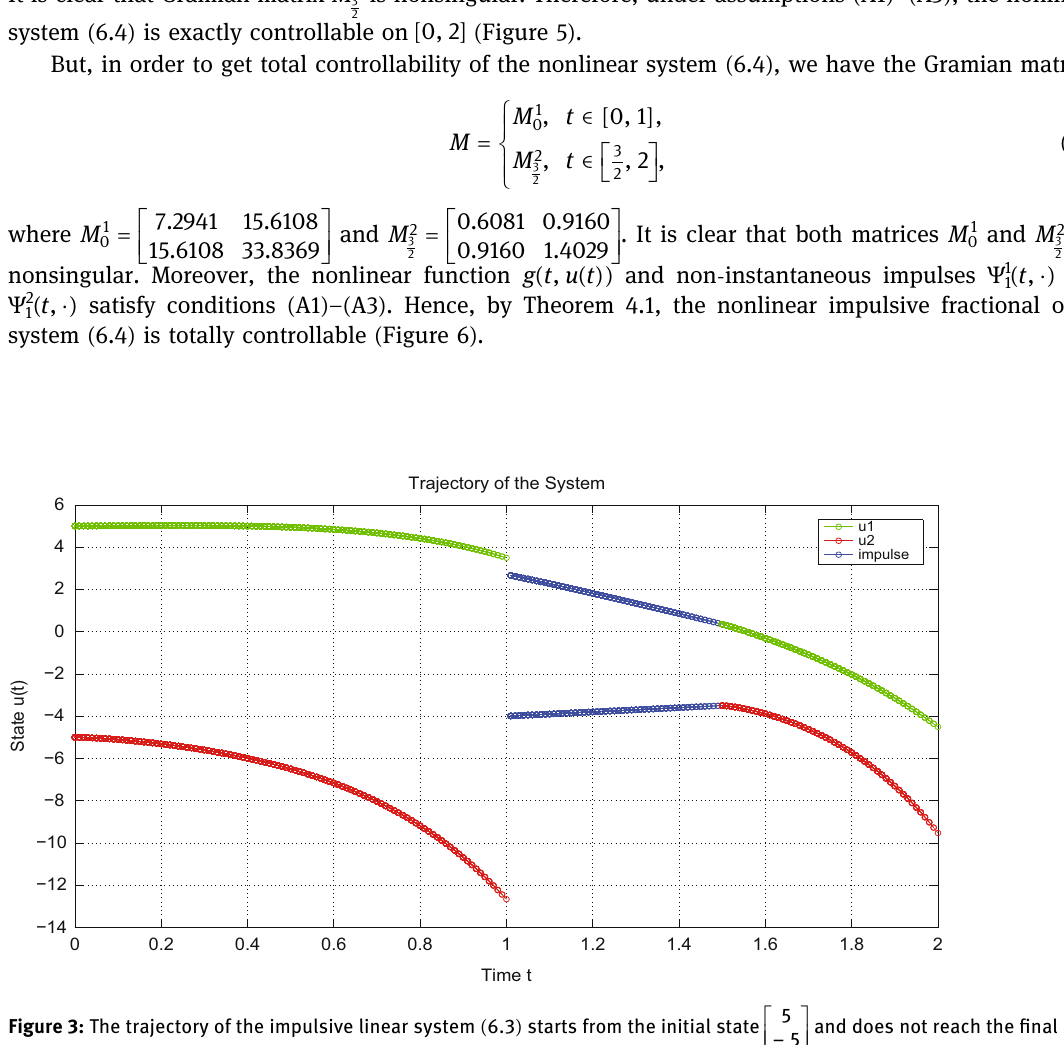
Figure 3: The trajectory of the impulsive linear system ( 6.3 ) starts from the initial state 0   on 0, 2 [ ]   5